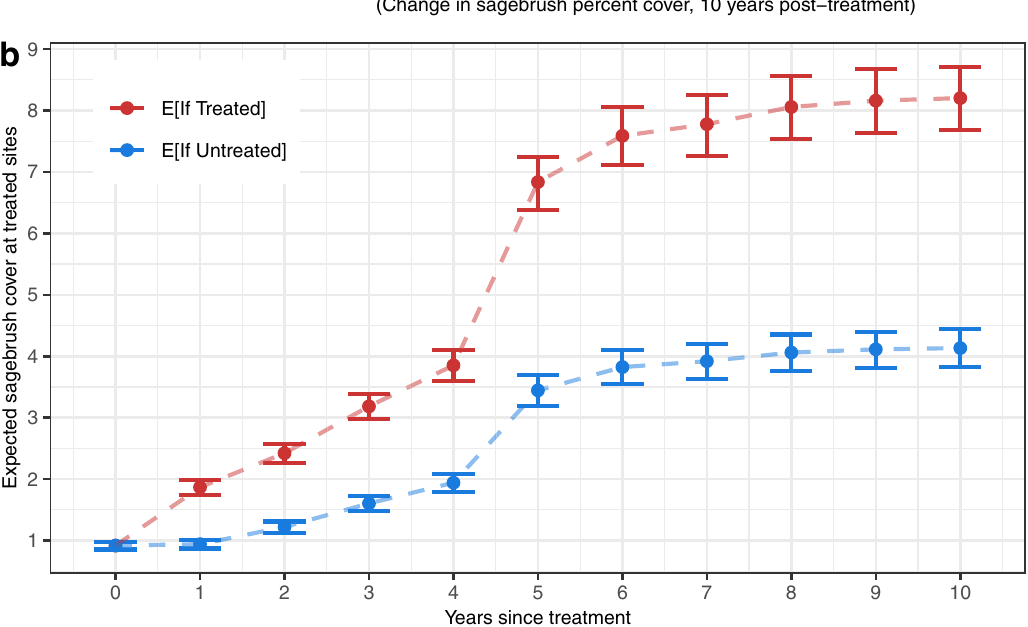
Fig. 4 Variation in estimated treatment effects among statistical approaches. a The predicted treatment effects (for treated sites) of post- fi re sagebrush seeding on sagebrush cover, identi fi ed by fi ve statistical approaches: (1) a naïve model examining only the difference in means between treated and untreated sites; regression analyses that incorporate either (2) propensity score matching or (3) environmental covariates, which considered measured sources of bias; (4) DiD estimation, which considered time-invariant unmeasured sources of bias; and (5) within-estimator panel regression, which additionally considered time-varying unmeasured factors. Dots represent median estimates, lines represent the 95% credible intervals (CIs), and grey density plots indicate full posterior. Red, grey, and purple intervals indicate negative, neutral, and positive estimated effects of restoration treatments on sagebrush recovery, respectively. b The expected (E[]) trajectories of sagebrush recovery if treated sites were to receive or not receive seeding treatments, over the 10 years following treatment. Dots indicate median estimates with 95% credible interval bars. Prediction intervals are constructed from posterior draws of the linear predictor for the within-estimator panel model, while holding weather covariates at their